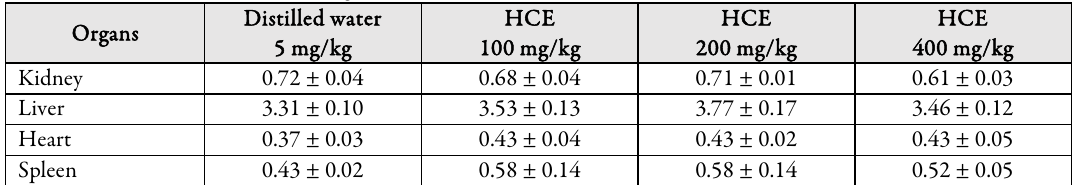
Table 2. Effects of HCE on organosomatic indices of treated rats Organs